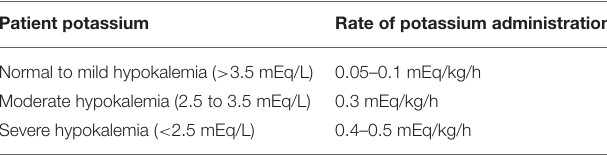
TABLE 3 | Guideline for potassium supplementation for hypokalemia. Patient